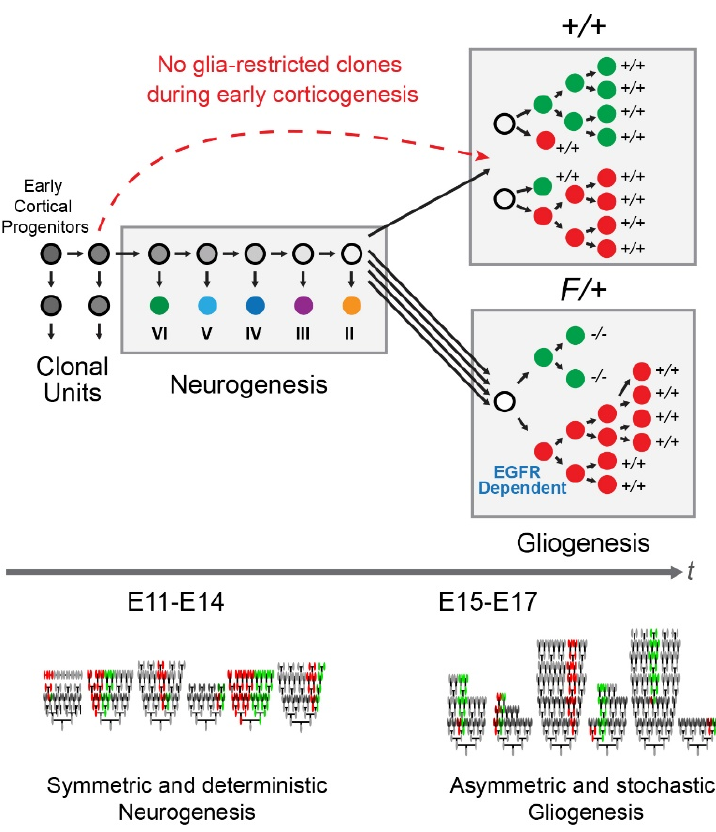
Figure 6. Summary: MADM enabled labeling of sparse clones in dorsolateral cortices of +/+ and F /+ mice reveals switch to gliogenesis around E15 followed by seeding of glia without involvement of glia-restricted clones from early neurogenic period. Allelic Egfr dosage analysis using MADM with a conditional allele for Egfr revealed that the background cells and their genotype ( Egfr-heterozygous ) influence Egfr-null (green) and wild type ( WT , red) MADM siblings. Comparison of cortical MADM progeny in +/+ and F /+ cortices exposed a dosage response in glial populations whereby WT MADM cells expand to compensate for loss of glia in their MADM green siblings. Neurogenic clones exhibit symmetric and deterministic patterns of expansion, whereas clonal expansion during gliogenesis is highly asymmetric and